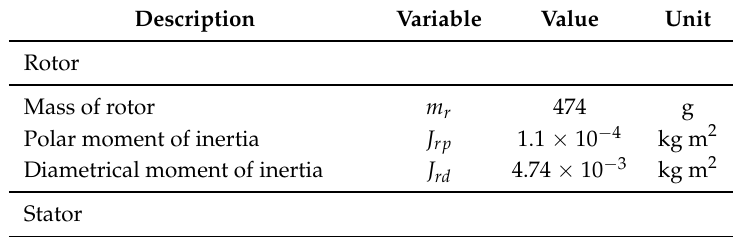
Table 1. Main parameters of the investigated system.